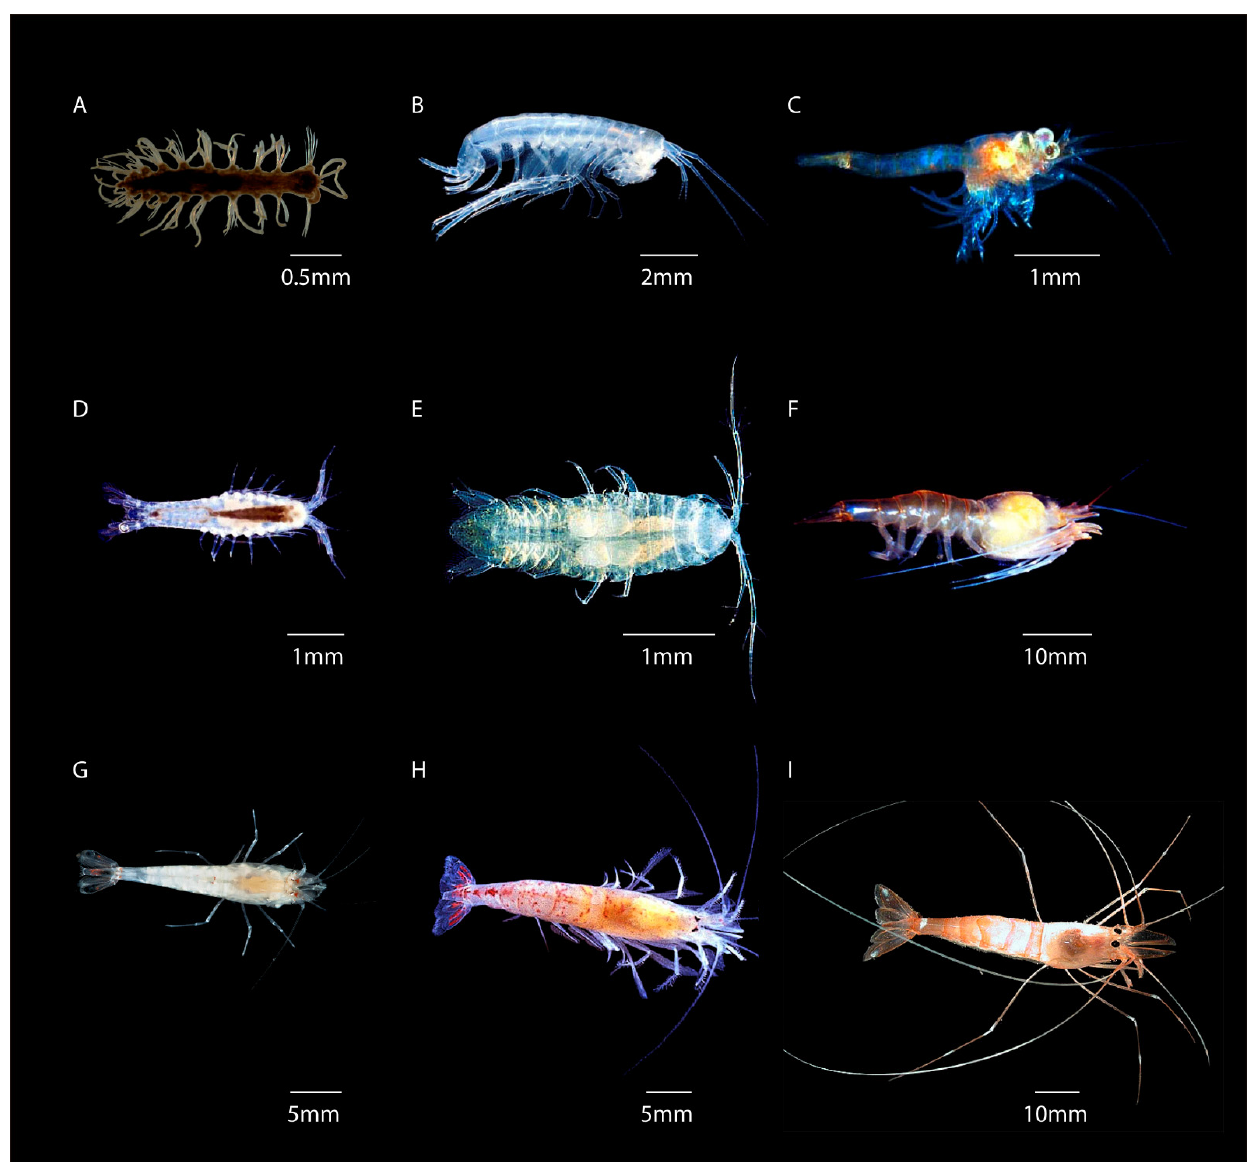
Figure 3. Examples of stygobiont species from the Walsingham cave system. ( A ) Leptonerilla prospera , ( B ) Pseudoniphargus grandimanus , ( C ) Bermudamysis speluncola , ( D ) Mictocaris halope , ( E ) Arubolana aruboides , ( F ) Barbouria cubensis , ( G ) Typhlatya iliffei , ( H ) Procaris chacei , and ( I ) Parhippolyte sterreri . Photo credits: ( A ) from Katrine Worsaae.